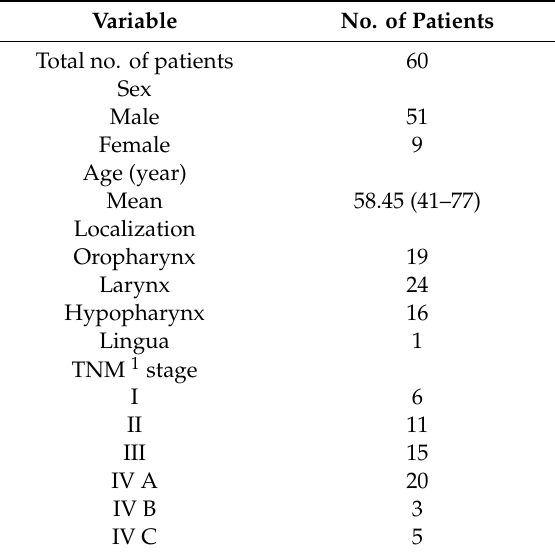
Table 4. Patient characteristics at time of